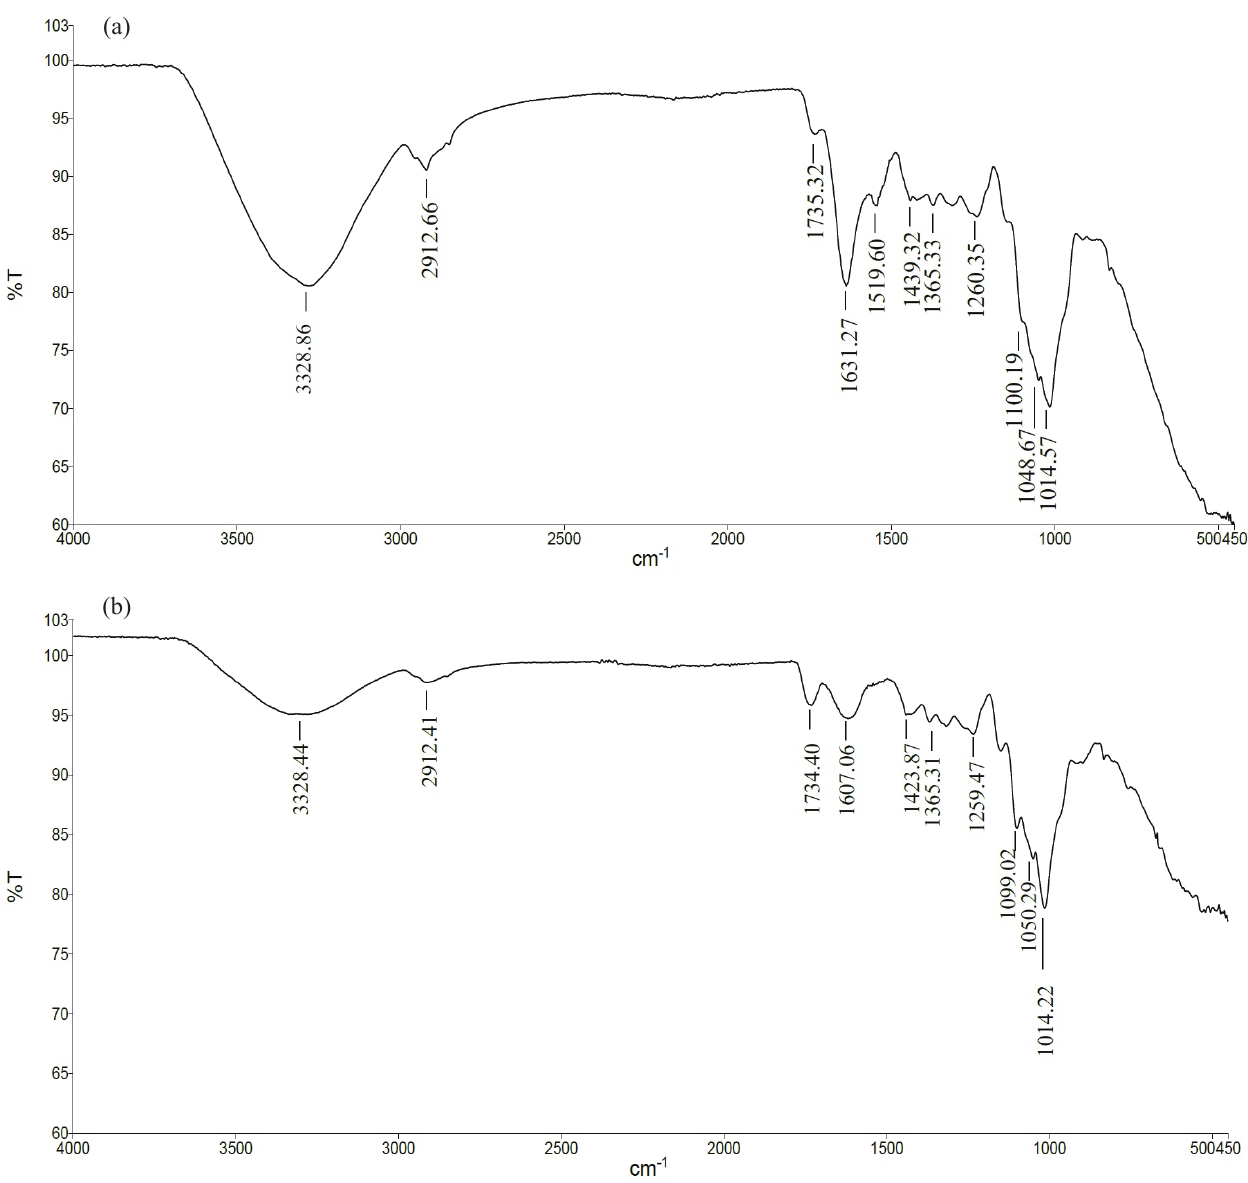
Fig. 2 – FTIR spectra of the support material prepared from grapefruit peel before (a) and after (b) treatment with 10 %v/v